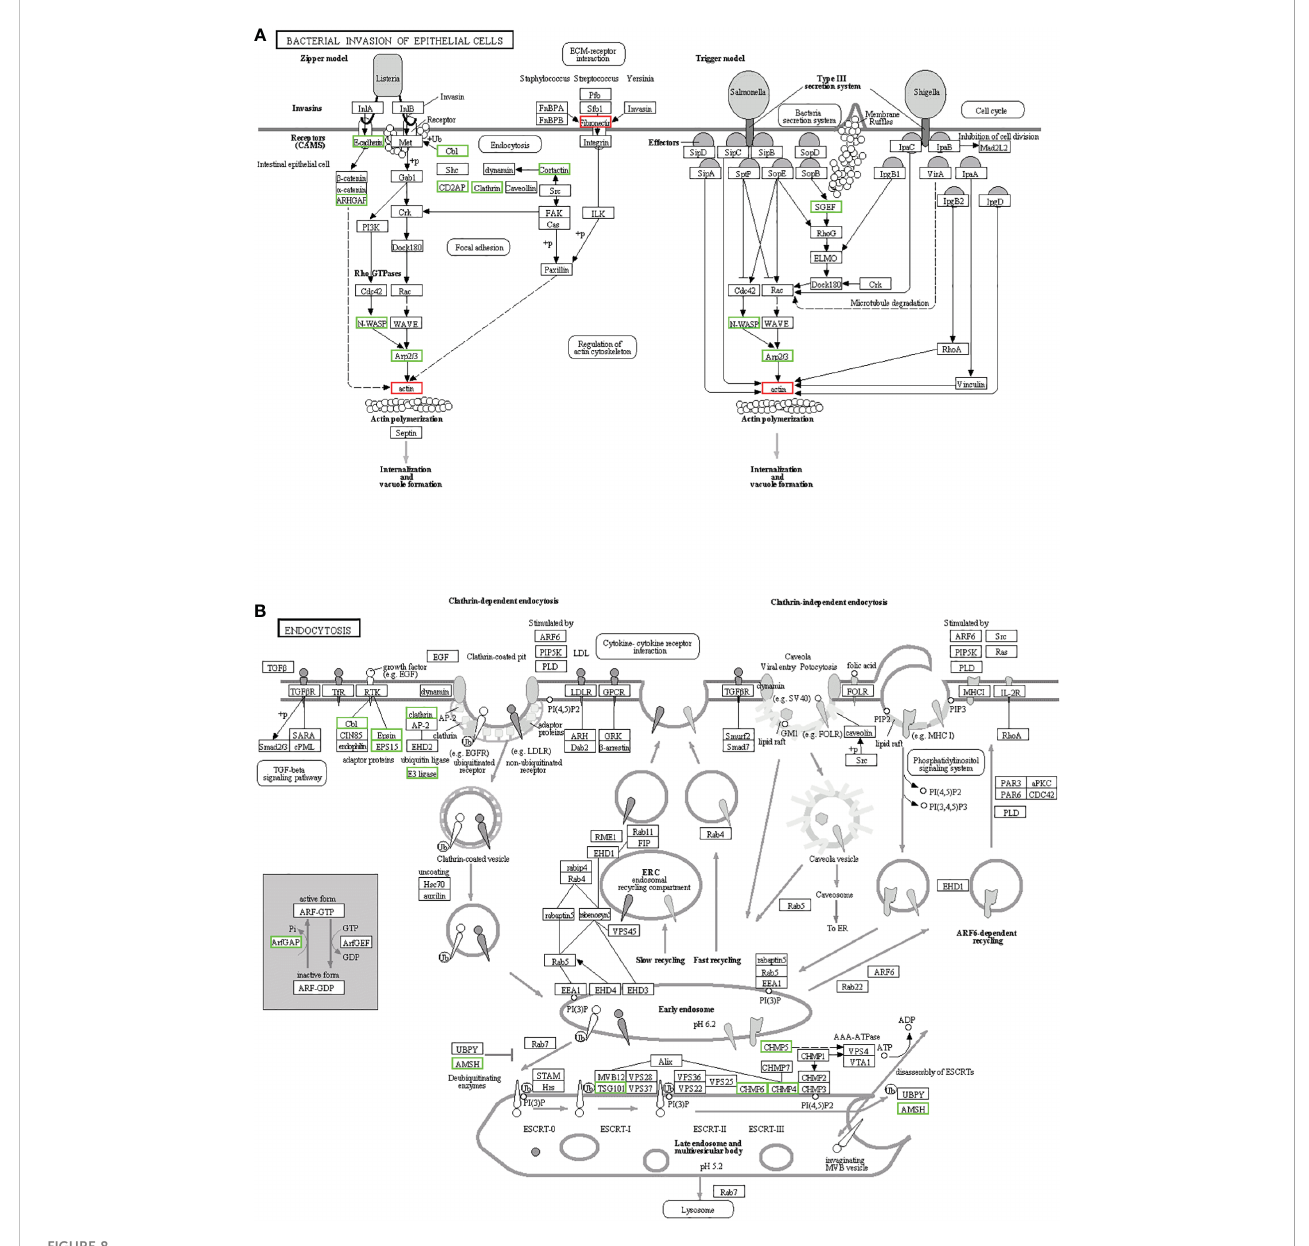
FIGURE 8 Kyoto Encyclopedia of Genes and Genomes (KEGG) pathways for the negative association of the identi fi ed proteins in the gills. (A) Bacterial invasion of epithelial cells. (B) Endocytosis. The differentially expressed proteins (DEPs) of the different pathways were upregulated ( red ) and downregulated ( green